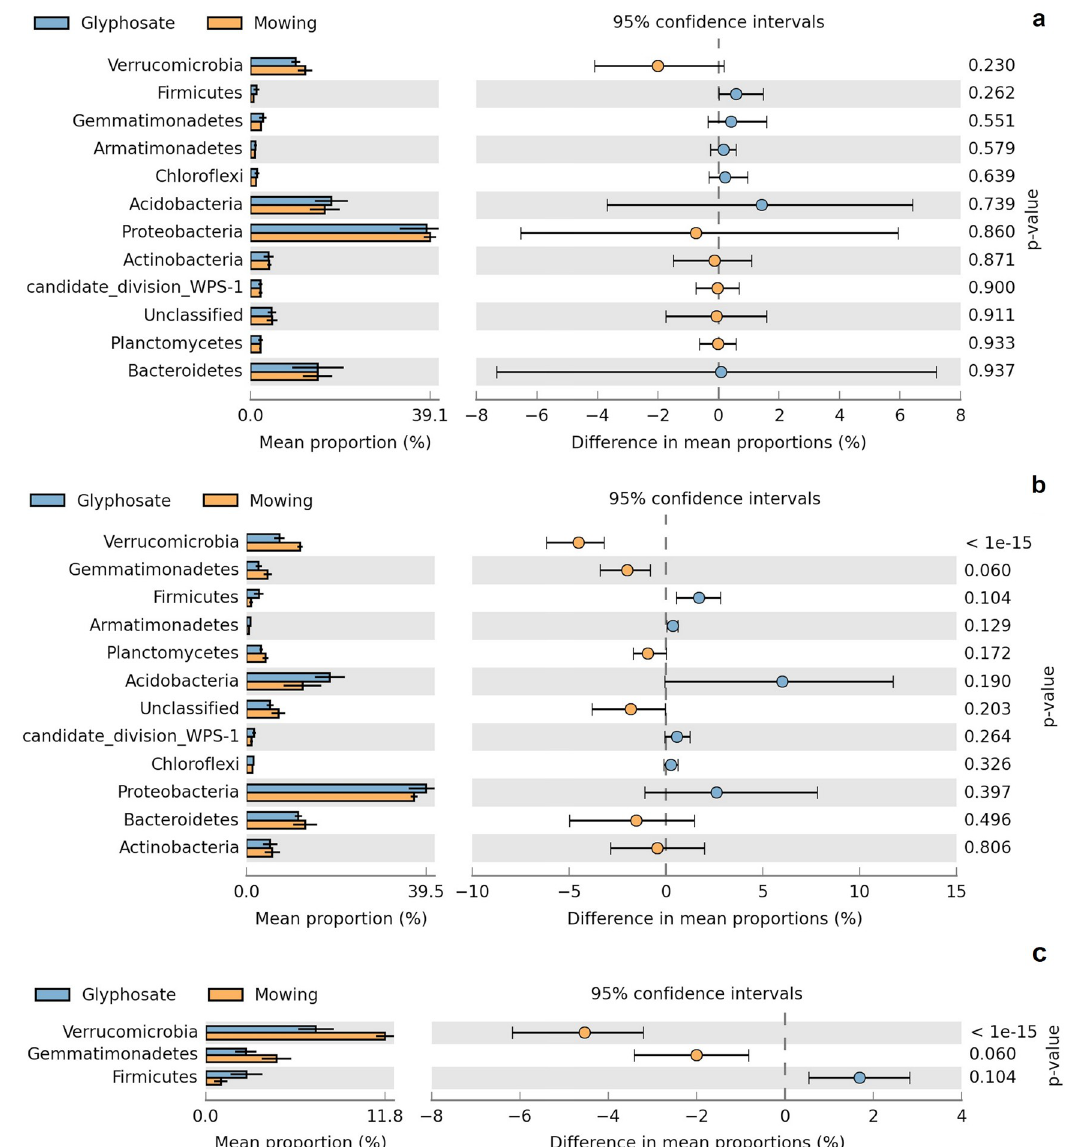
Fig 3. Comparison of mean relative abundance between suppression methods at phylum level. Panel a: 4 days (without effect size filters), Panel b: 26 days (without effect size filters). Panel c: 26 days (with effect size filters: |DP| > 1.5%; RP > 1.5). At 4 days after suppression, differences in mean proportions (DP) and in the ratio of proportions (RP) did not pass the filtering step. White’s non- parametric t-test was used for statistical analysis ( α = 0.05). Only those categories with a minimum relative abundance of 0.25% in each sample are shown. Category “ Unclassified ” refers to bacterial sequences without taxonomic affiliation. Confidence intervals and P -values are indicated in each